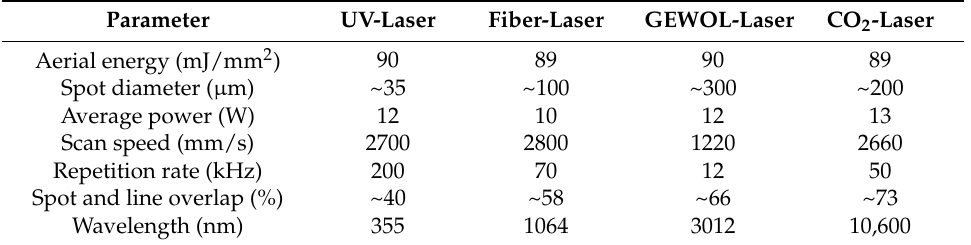
Table 1. Laser parameters for pre-treatment with different laser sources.